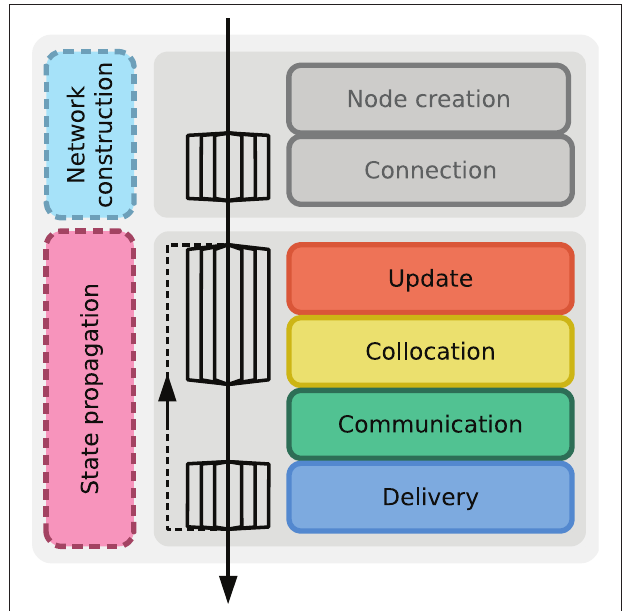
FIGURE 3 | Instrumentation to measure time-to-solution. Successive phases of a NEST simulation; time is indicated by top-down arrow. Fanning arrows denote parallel operation of multiple threads. The main phases network construction (cyan) and state propagation (pink) are captured by external timers on the Python level. Built-in NEST timers on the C++ level measure sub-phases: node creation and connection (both gray, not used in benchmark plots); update (orange), collocation (yellow), communication (green), and delivery (blue). The sub-phases of the state propagation are repeated until the simulation is finished as shown by the dashed arrow connecting delivery and